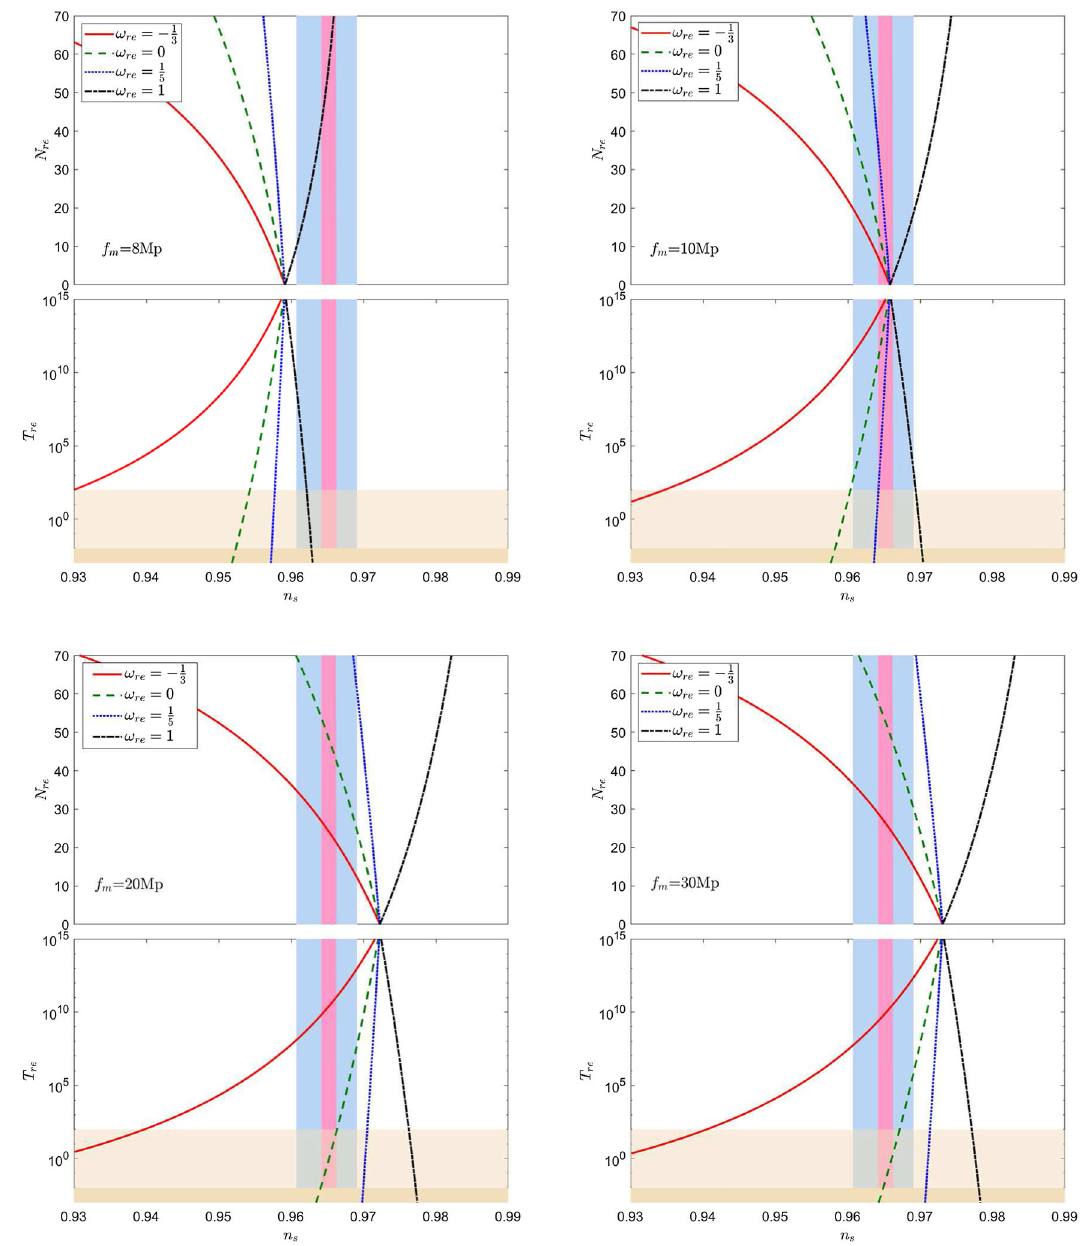
Fig. 3 T re and N re as a function of n s for different f m and ω re in the SNI model. The red solid, the gree dashed, the blue dotted and the black dottedanddashedlinecorrespondsto ω re = − 1 ω = 1, respectively. The blue region corresponds to the 1 σ boundary re